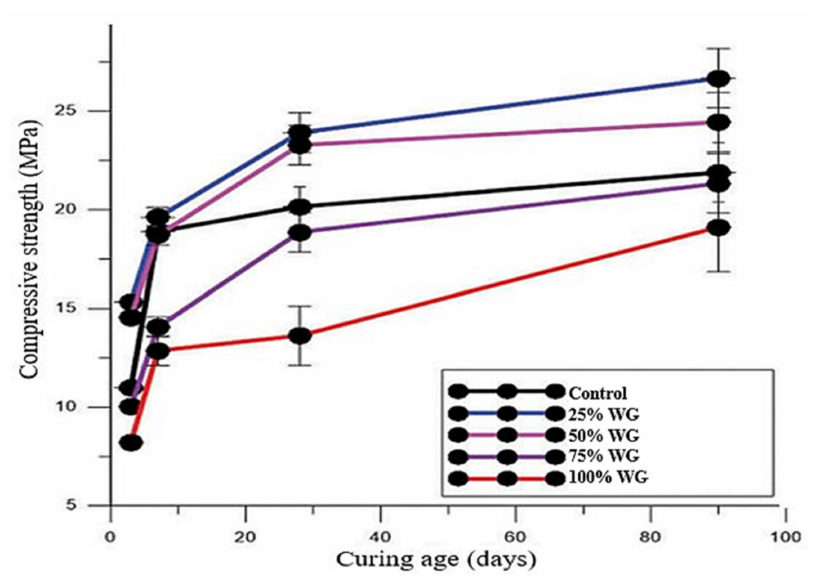
Figure 14. Compressive strength of concrete with WG aggregates (particle size 0.8–5 mm) in the replacement of sand [84].